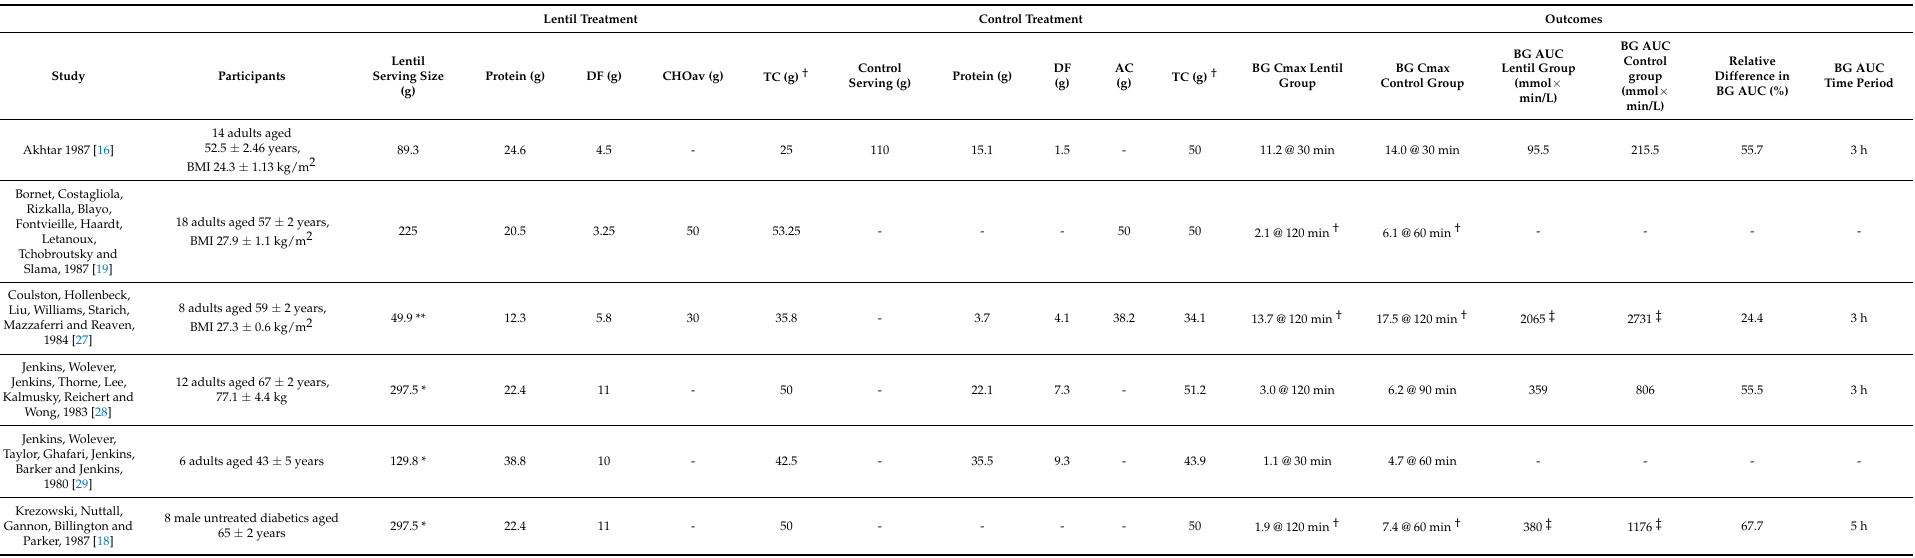
Table 2. Summary of data obtained from studies of subjects with